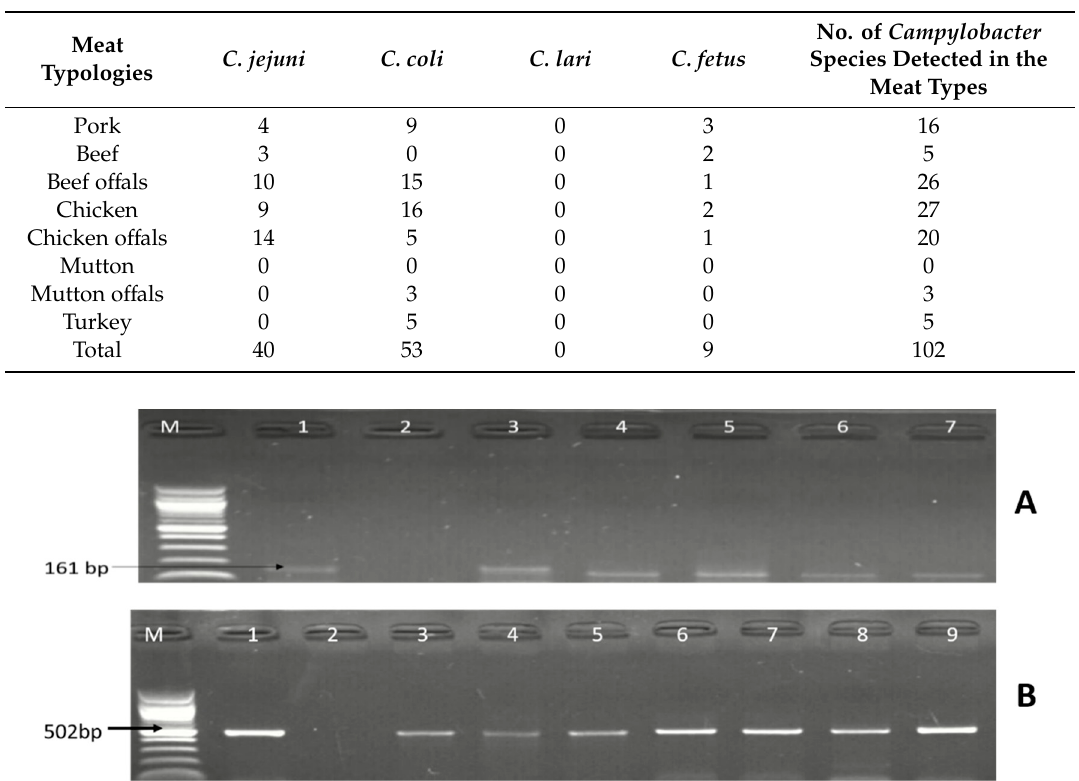
Table 2. Summary of Campylobacter species identified in the meat types.